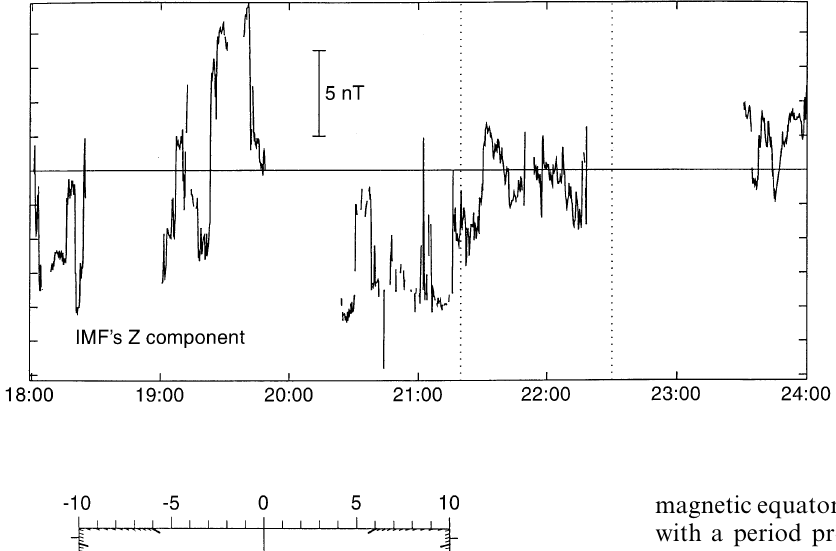
Fig. 3. The IMF’s Z component measured in the solar wind by the IMP-8 satellite (position (cid:77) 29.7, 12.3, ! 15.1 (cid:78) R (cid:69) in GSM). The dotted lines span the interval (21 (cid:50)(cid:48) — 22 (cid:51)(cid:48) UT) covered by Figs. 6 — 8